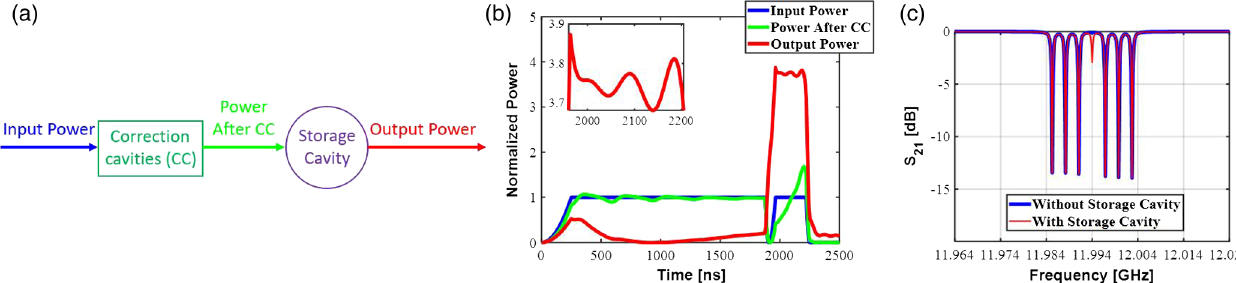
FIG. 1. (a) Scheme, (b) pulse shape, and (c) transmission spectrum of the pulse compression system of klystron-based 380 GeV CLIC option. The blue, green, and red curves in (b) are the input power, power after the correction cavity chain, and output power, respectively. The inset of (b) is given to show an enlarged view of output power. The Q 0 of storage cavity and coupling factor are 2 . 4 × 10 5 and 6. The 6 . 0 × 10 4 and 1.48. Phase-to-amplitude modulation by using two klystrons could be applied Q 0 of correction cavity and coupling factor are to eliminate the ripples of the output pulse [3]. The blue and red curves in (c) are the transmission spectra of the correction cavity chain and the whole system. The frequency difference between two nearby peaks is 2.9 MHz, which corresponds to the pulse length of 344 ns.